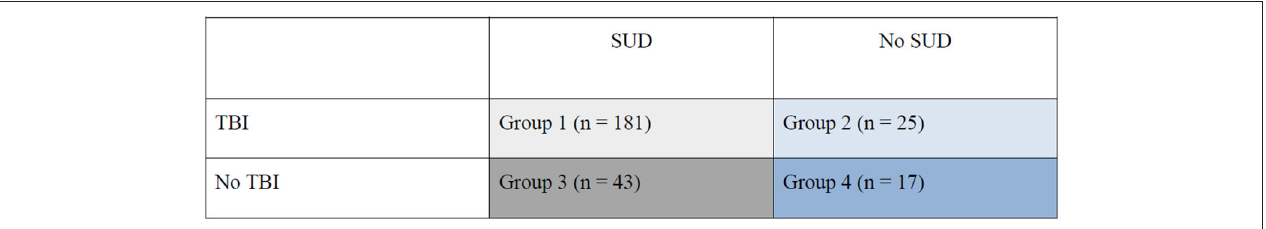
FIGURE 1 | Groups of young violent offenders with or without TBI and/or